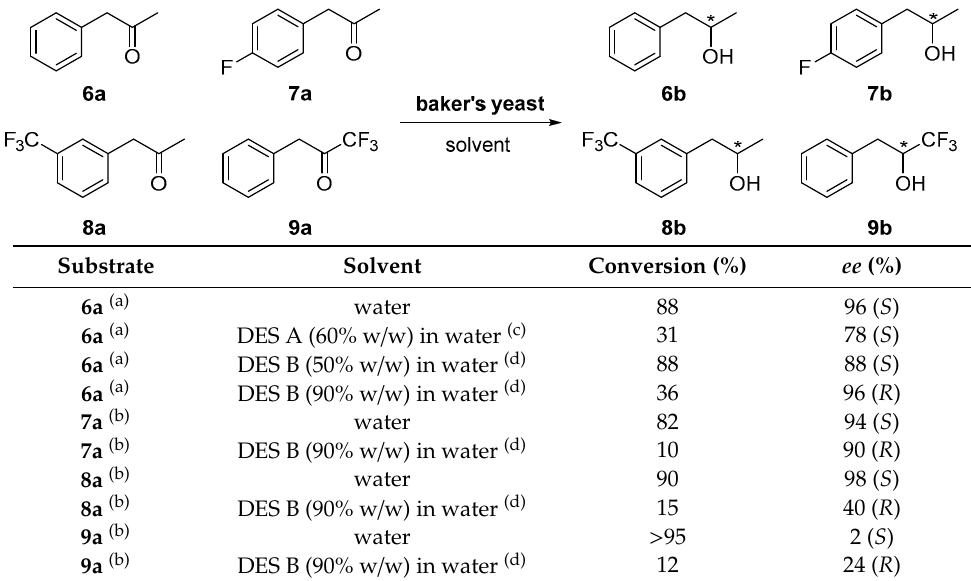
Table 2. Selective reduction of ketones 6-9a to their corresponding enantioenriched alcohols 6-9b using baker’s yeast in different solvent conditions [38].